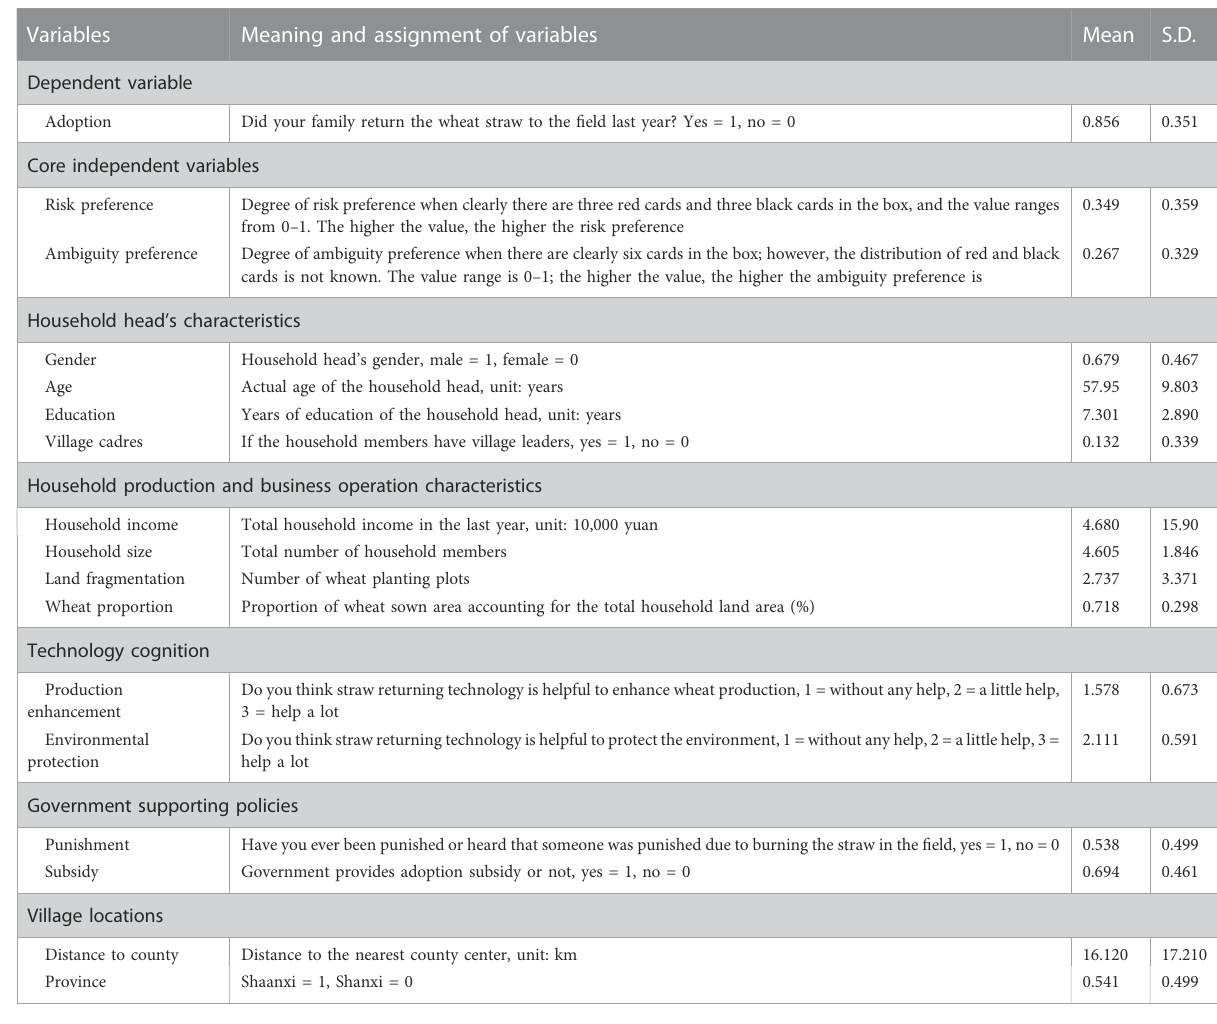
TABLE 5 De fi nition and descriptive statistics of